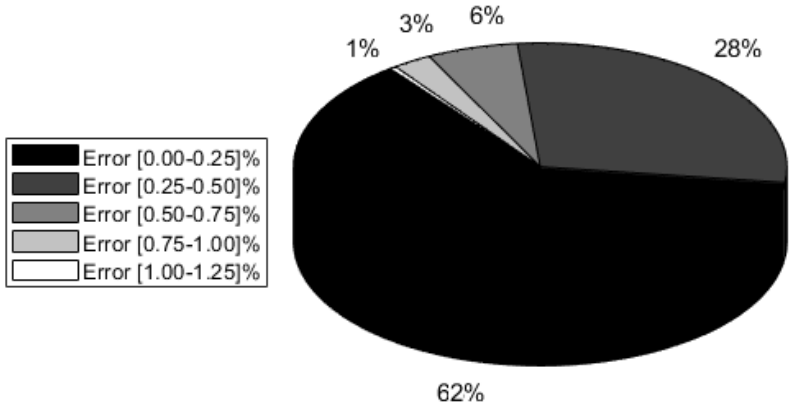
Figure 11. Error distribution in % of forecaster 6 (period January–August 2018).